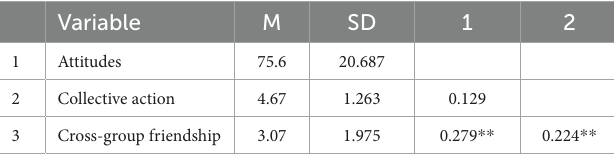
TABLE 4 Means, standard deviations and